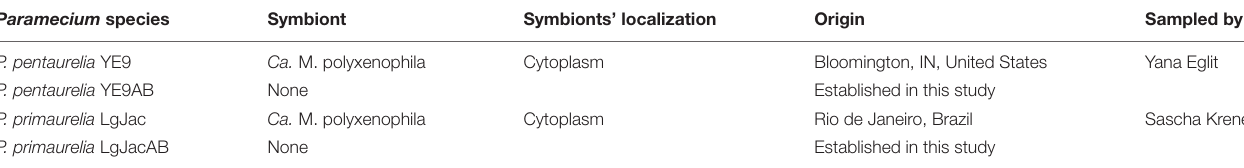
TABLE 1 | Paramecium species used in this study, their endosymbionts and geographic origin. Paramecium